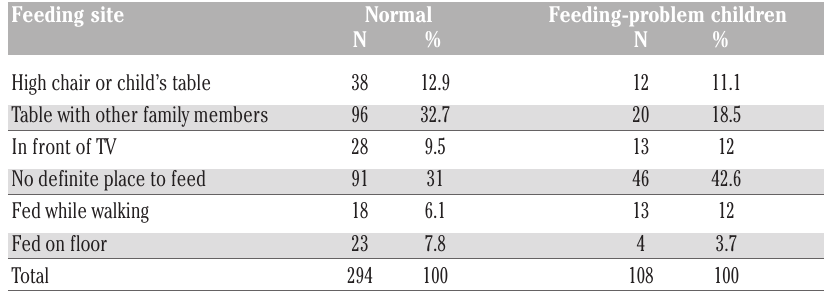
Table 6. Feeding site in normal and feeding-problem